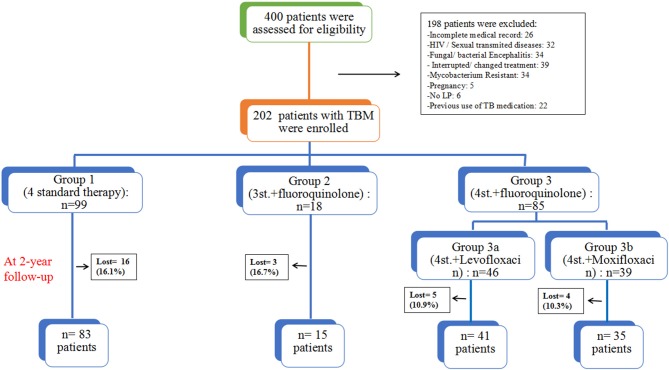
The assessment process and study design; all patients were grouped based on their treatment regimens.